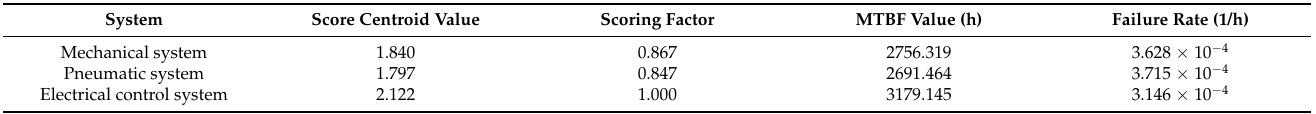
Table 8. The expected MTBF of each system of the loading and unloading truss robot for CNC